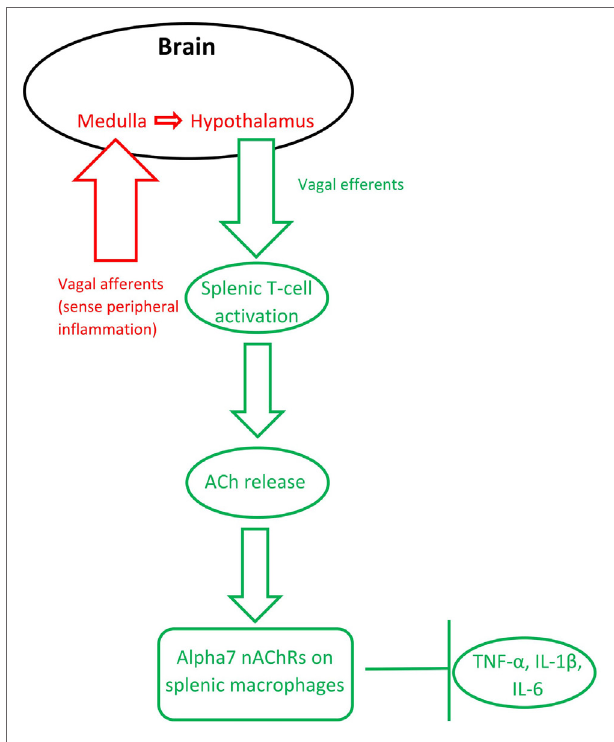
FiGURe 1 | The inflammatory reflex (red) and the cholinergic anti- inflammatory pathway (green). Based on Steinberg et al. (50) and Gallowitsch-Puerta and Pavlov